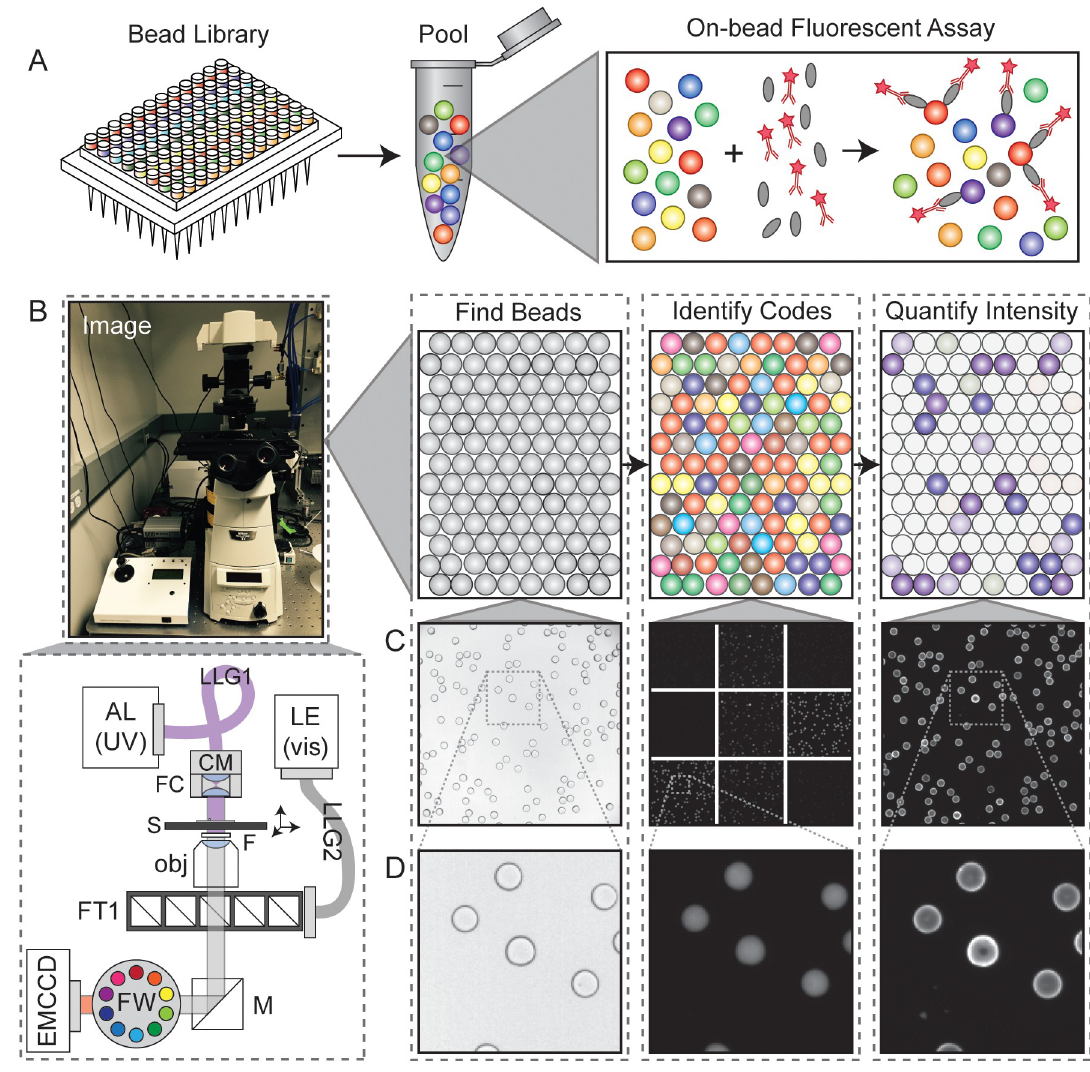
Fig 1. Overview of the experimental and analysis pipeline. A) Diagram of the MRBLE library assay. B) Photograph and optics schematic of the imaging setup (left) and overview of data analysis pipeline (right). AL = arc lamp; LE = LED light engine; LLG = liquid light guide; CM = condenser mount; FC = focusing collimator; S = sample and stage; F = UV blocking filter mounted on top of the objective within a 3D printed holder; obj = CFI Plan Achromat 4x objective, NA of 0.2; FT = filter turret; M = mirror; FW = filter wheel; EMCCD = Andor iXon EMCCD camera. C) From left to right: bright-field image of MBRLEs; images of the 9 emission channels for decoding; image of the Cy5 channel used for assay quantification. D) Close-ups of bright-field image of MBRLEs; one emission channel (620 nm, which corresponds to a specific peak in Europium); and image of the Cy5 channel used for assay quantification.